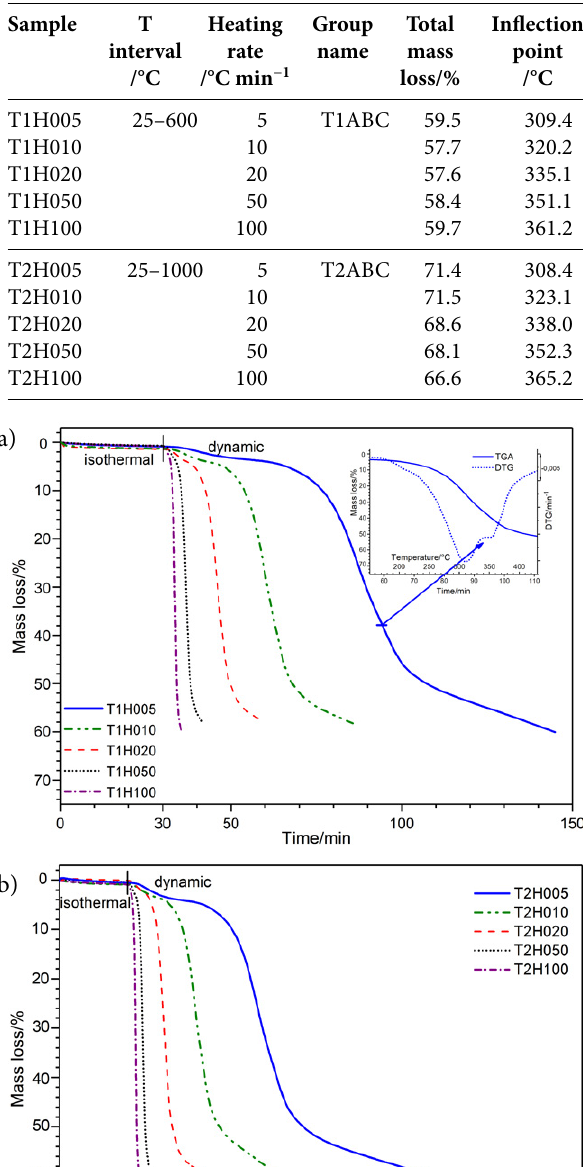
Table 1. Sample abbreviations and comparison of the results of the dynamic pyrolysis measurements up to 600 °C and up to 1000 °C.